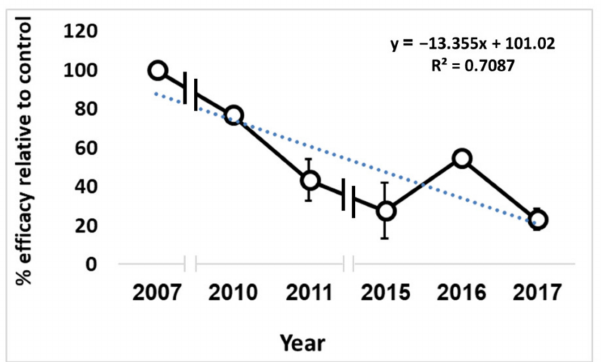
Figure 1. Changes in the efficacy of kresoxim-methyl in the control of apple scab in 9 different orchards in the Golan and Galilee regions during the last decade. Data represent the calculated efficacy against leaves or fruits scab, compared to control untreated trees in each orchard. The mean efficacy is presented in case of several experiments conducted in the same year (2011, 2015 and 2017). Bars represent the standard error of the mean.